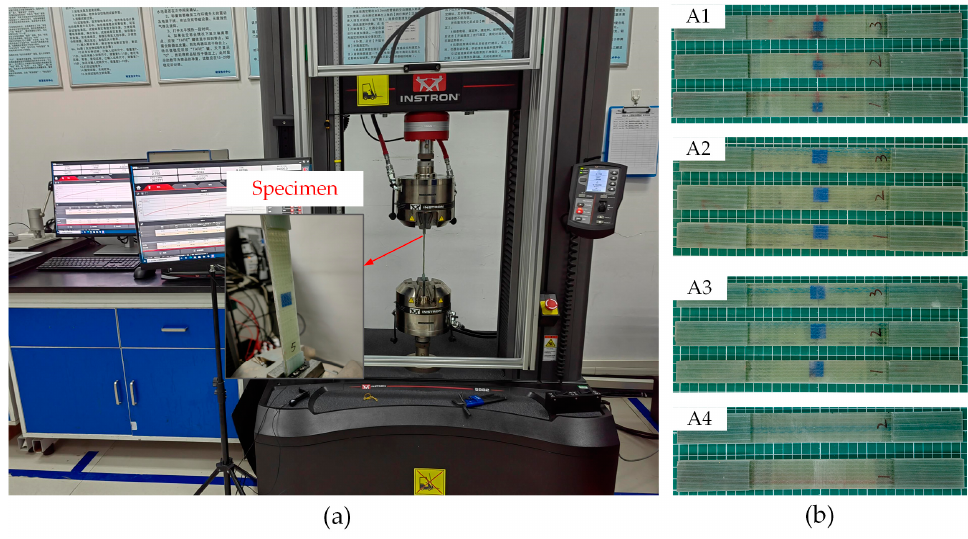
Figure 5. Tensile test: ( a ) test system; ( b ) Partial A1–A4 specimens.